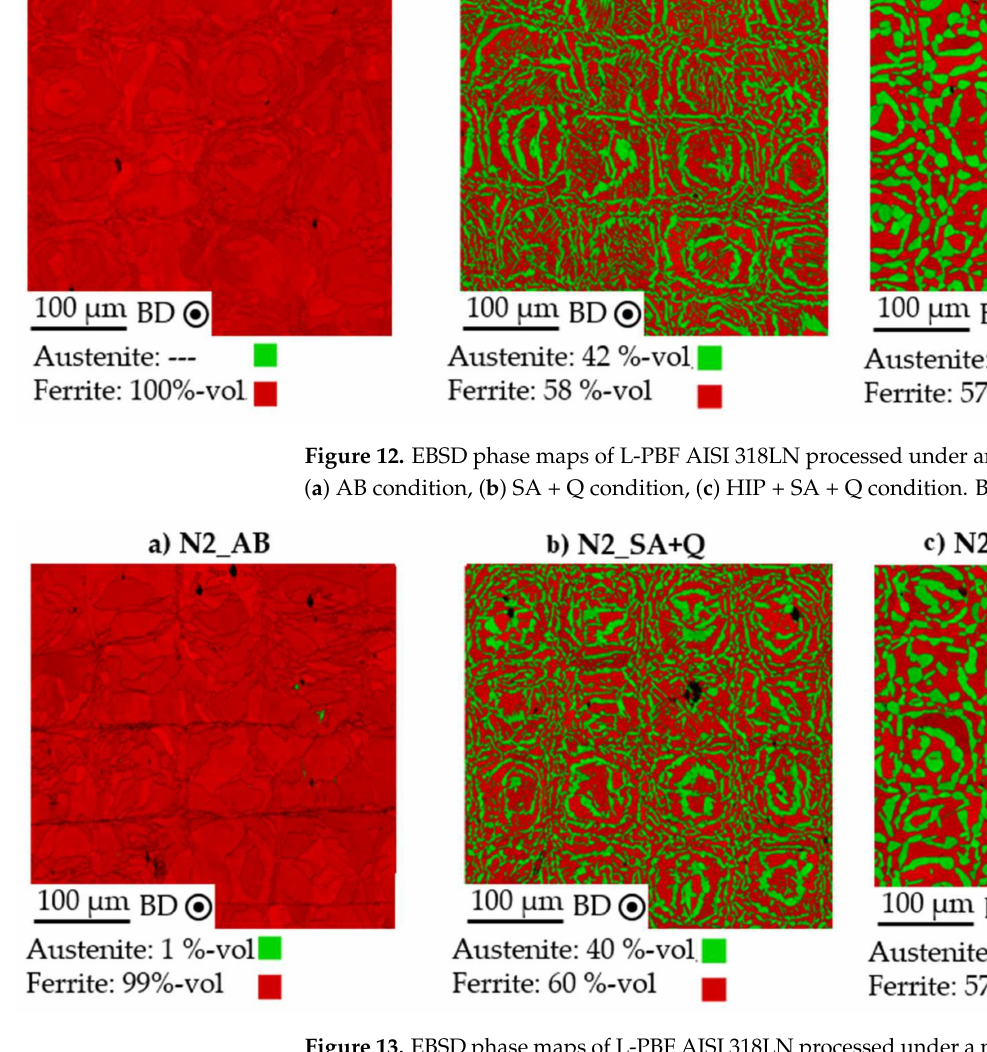
Figure 13. EBSD phase maps of L-PBF AISI 318LN processed under a nitrogen protective